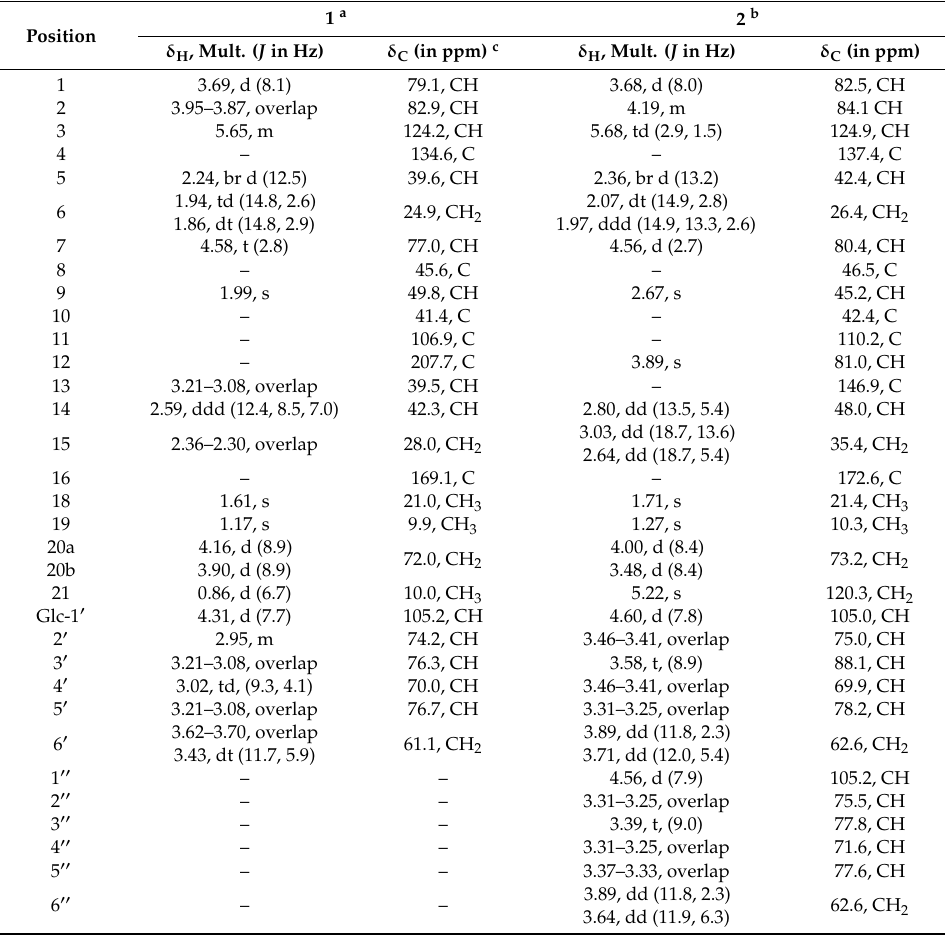
Table 2. NMR data of Compounds 1 and 2